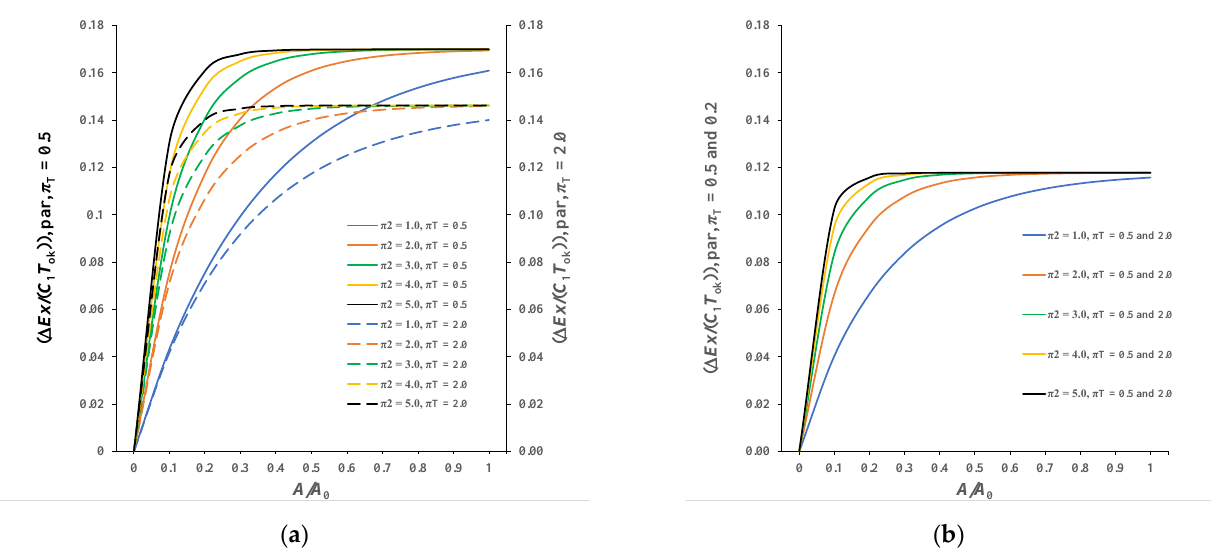
Figure 5. Local exergy destruction of a parallel-flow recuperator for π T = 0.50 and 2.0: ( a ) π 3 = 0.50; ( b ) π 3 = 1.0.